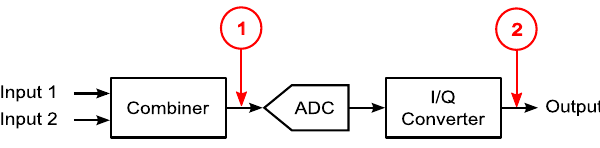
FIG. 3. Two-tone measurement setup. Test point 1 is the output of the combiner and is measured by a spectrum analyzer. Test point 2 is the output of the I=Q converter and is estimated using Eqs. (2) and (3). The magnitude of the I=Q converter output is changed